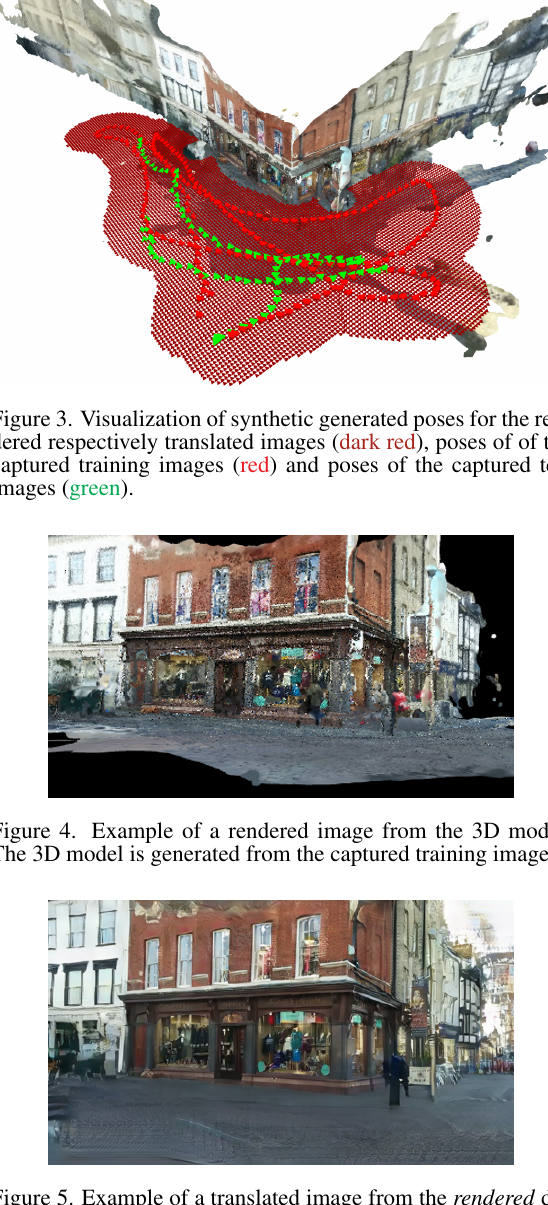
Figure 5. Example of a translated image from the rendered do- main into the captured domain by image translation. This im- age was translated from the rendered image shown in Figure